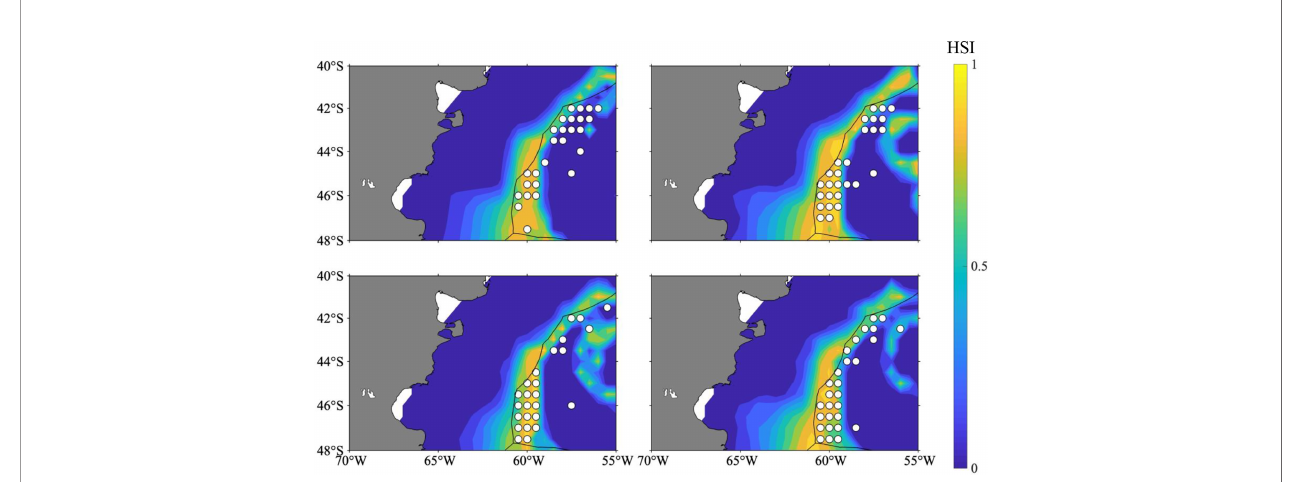
FIGURE 3 | Spatial distribution of HSI overlaid with fi shing location in 2017 (the white circle indicates the fi shing location) (the results of forecasting).